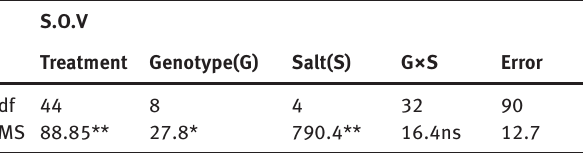
Table 1: Analysis of variance of germination percentage data S.O.V